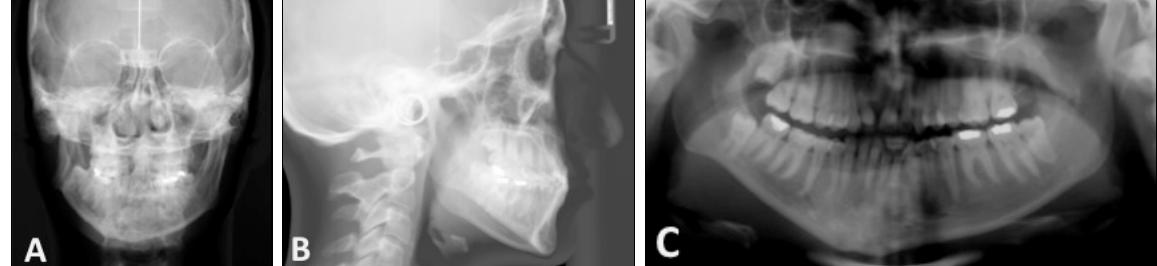
Figure 1. Pretreatment facial and intraoral photographs.